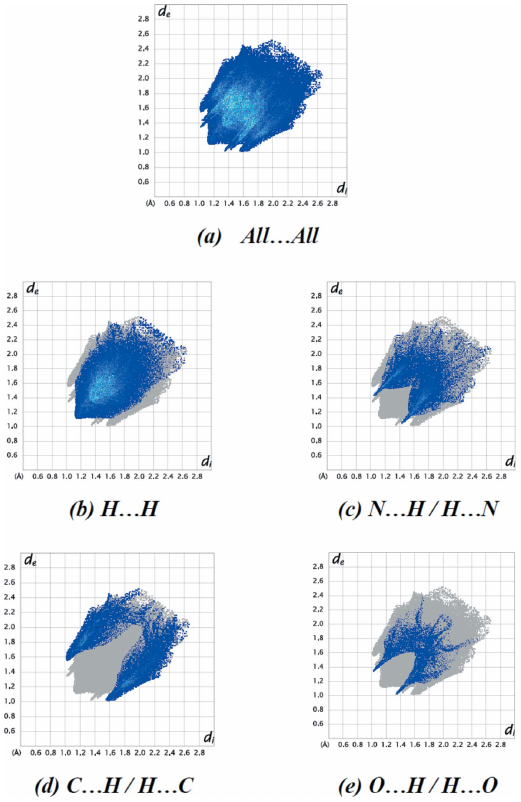
Figure 7 The two-dimensional fingerprint plots of the title compound, showing ( a ) Figure 5 all interactions, and delineated into ( b ) H (cid:2)(cid:2)(cid:2) H, ( c ) N (cid:2)(cid:2)(cid:2) H/H (cid:2)(cid:2)(cid:2) N, ( d ) A general view of the packing in the unit cell of the title compound with C (cid:2)(cid:2)(cid:2) H/H (cid:2)(cid:2)(cid:2) C and ( e ) O (cid:2)(cid:2)(cid:2) H/H (cid:2)(cid:2)(cid:2) O interactions. [ d e and d i represent the C—H (cid:2)(cid:2)(cid:2) (cid:2) interactions indicated (dashed lines). [Symmetry codes: (iii) distances from a point on the Hirshfeld surface to the nearest atoms (cid:5) x + 1, y (cid:5) 1 , (cid:5) z + 3 ; (iv) (cid:5) x + 1, y + 1 , (cid:5) z + 3 ]. outside (external) and inside (internal) the surface, 2 2 2 2